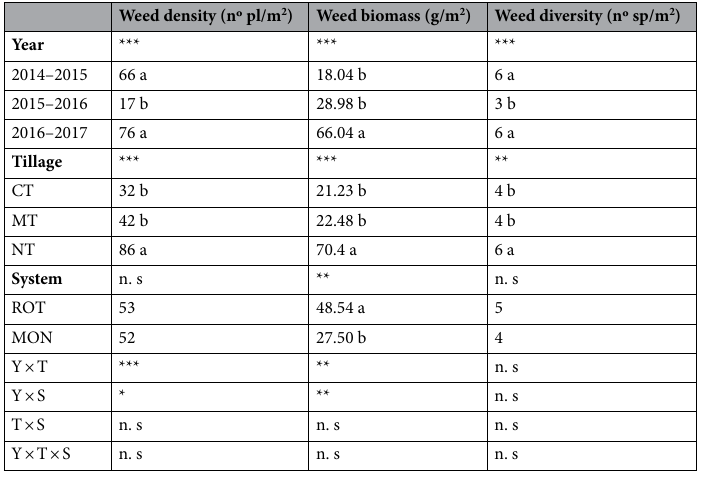
Table 3. Analysis of variance results for years, tillage system, and crop system. Mean values for weed density, weed biomass, and weed diversity. Different letters in each column indicate a difference between treatments according to HSD Tukey’s Test with 95% probability level ( p < 0.05); *** = 0.05; ** = 0.1; * = 0.5 CT conventional tillage, MT minimum tillage, NT no tillage, ROT rotation, MON monoculture, Y year, T tillage, S